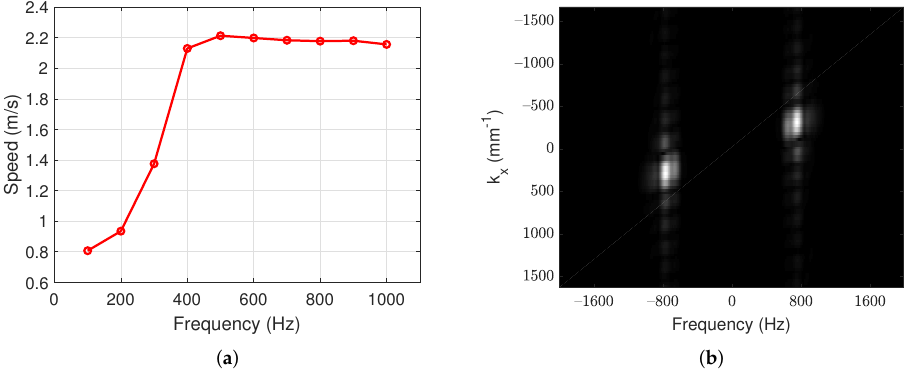
Figure 3. The results of mechanical wave elastography in homogeneous phantom. ( a ) Wave speed for various excitation frequencies and ( b ) frequency spectrum on excitation frequency of 750